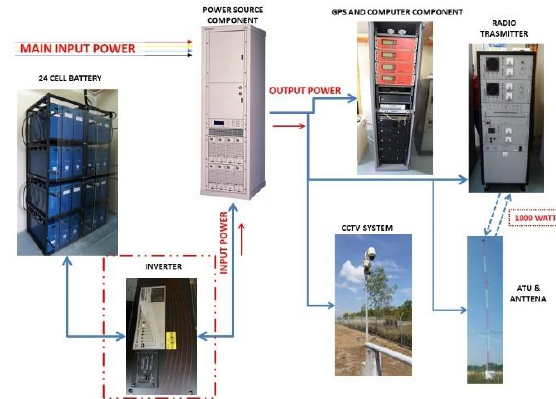
Figure 4. SISPELSAT broadcasting station main component